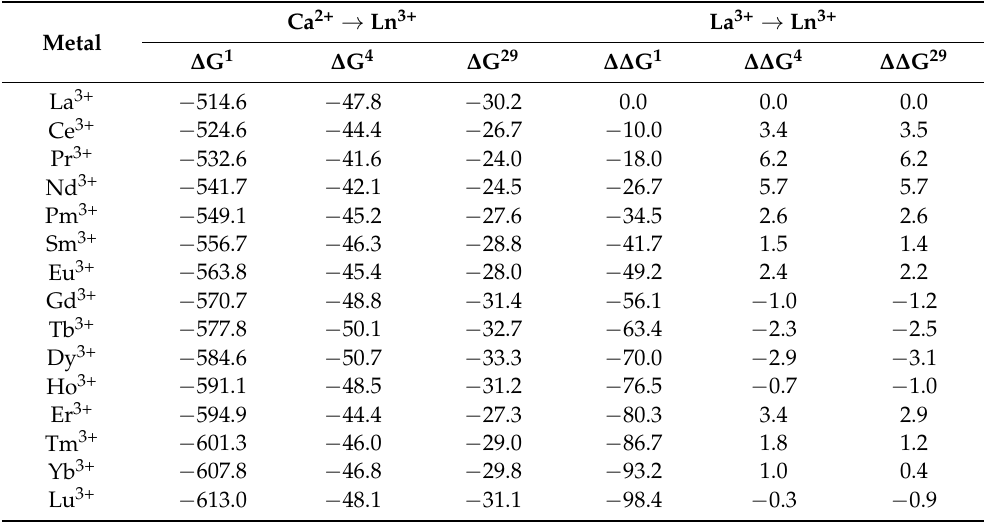
Figure 2. M062X/6-311++G**//SDD fully optimized Ca 2+ and La 3+ -loaded metal binding sites of calcium-signaling/buffering proteins: ( A ) Site 1, ( B ) Site 2 and ( C ) Site 3. Enthalpies and Gibbs energies (in kcal mol − 1 ) of the Ca 2+ → La 3+ substitution are also given. Superscript 1 stands for the process in the gas phase, whereas superscripts of 4 and 29 signify metal exchange reactions taking place in buried and solvent-accessible binding pockets, respectively. Table 1. Free energies of the Ca 2+ → Ln 3+ and La 3+ → Ln 3+ exchange (in kcal mol − 1 ) for Site 1.